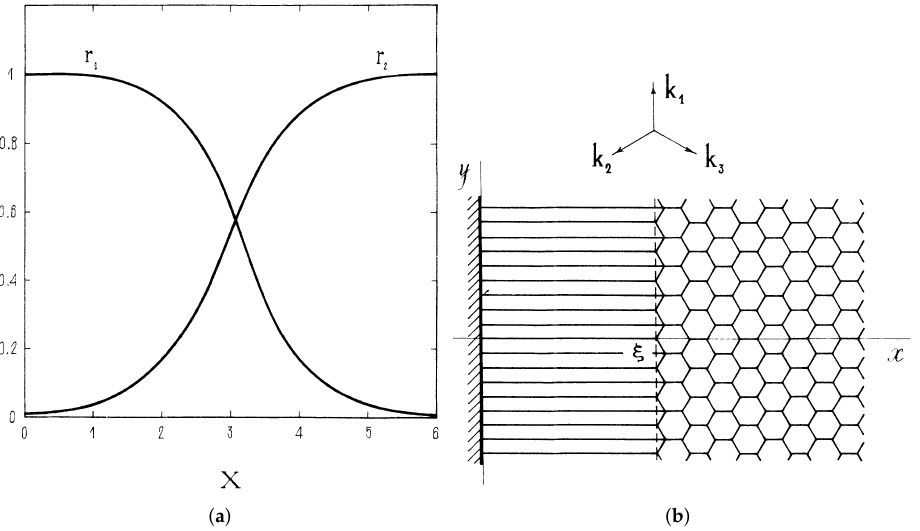
Figure 3. ( a ) A typical profile of the DW between different plane-wave (roll) families. ( b ) The structure of the DW between the plane-wave and hexagonal patterns (in this panel, k 1,2,3 are identical to n l in Equation (37)). Figure is reprinted with permissions from Ref.